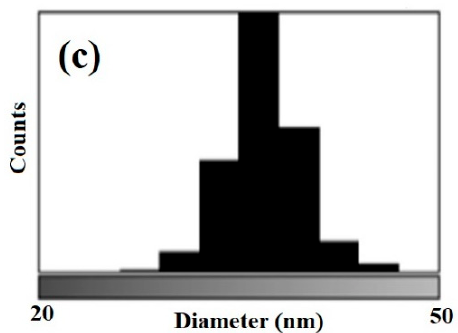
Figure 5. ( a ) 40 ◦ tilted view SEM image of perpendicular ZnO NWs arrays grown on ZnO SL / Si (100) substrates at 10 mTorr, ( b ) top view SEM image of the as-grown ZnO NWs, ( c ) corresponding size distribution histogram of the ZnO NWs arrays.